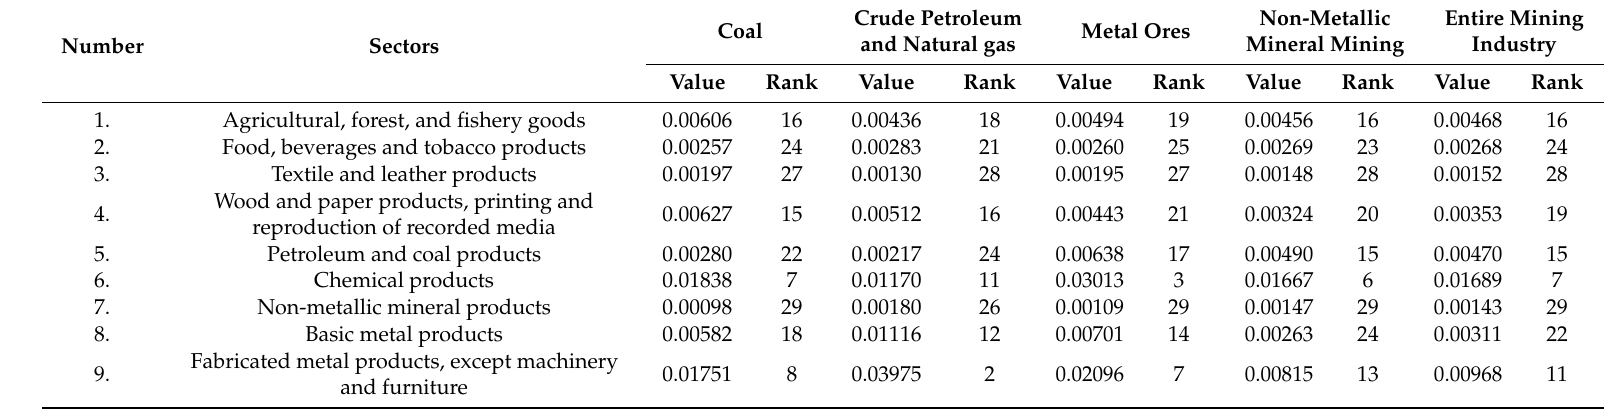
Table 3. Value-added creation e ff ects of mining